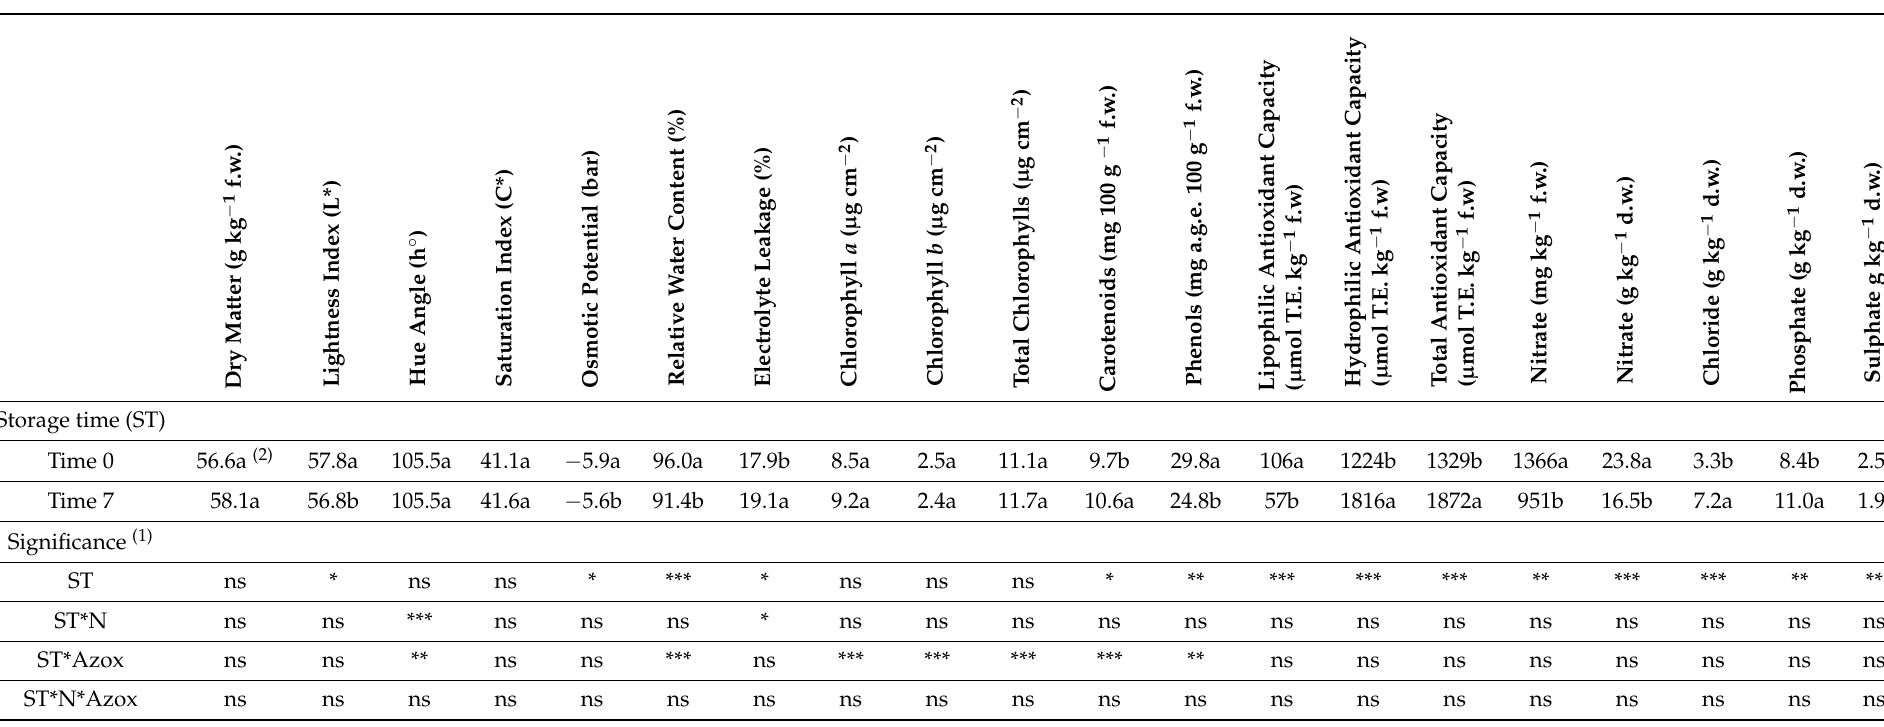
Table 4. The significance of F test of ANOVA for the effects of storage time (ST), N rate (N), azoxystrobin application time (Azox) and their interactions on biometrical, physiological, and nutritional traits in butterhead lettuce